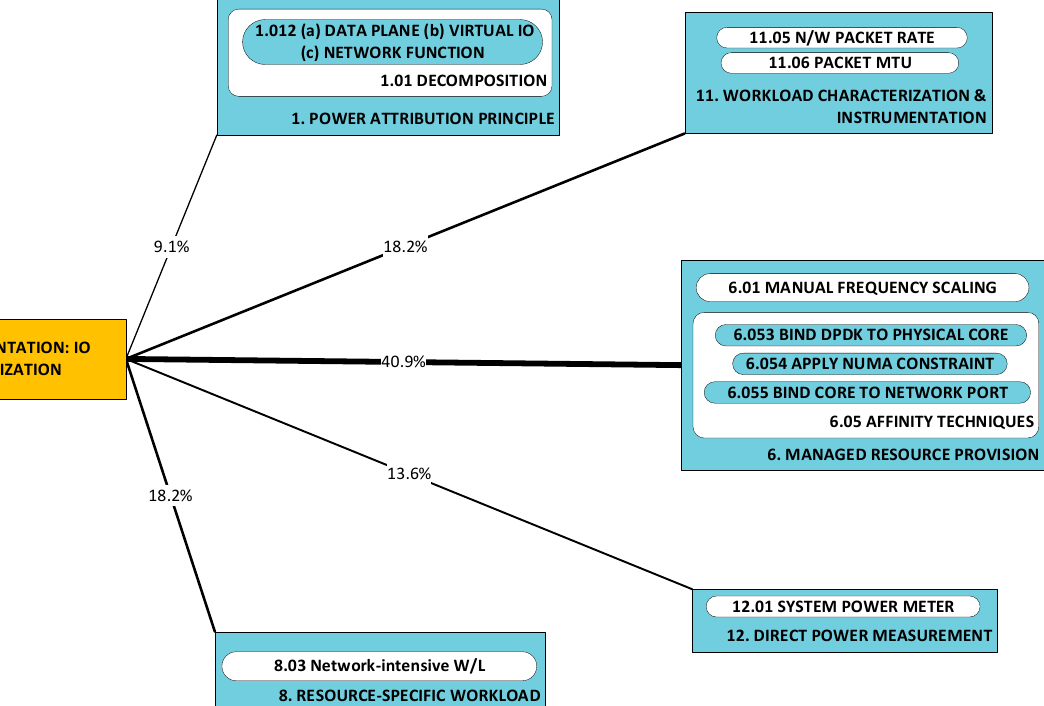
Figure 14. Approaches to solving challenges in category P9; utility metric U A thickness and as a percentage. RUs in the respective categories are the following: P9 [51,53]; A1 [53]; A6 [51]; A8 [51,53]; A11 [53]; A12